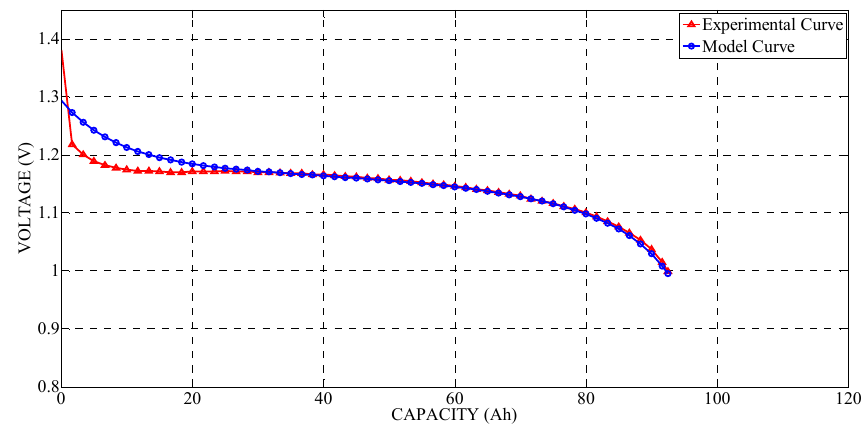
Figure 19. Discharge curve (1 C).